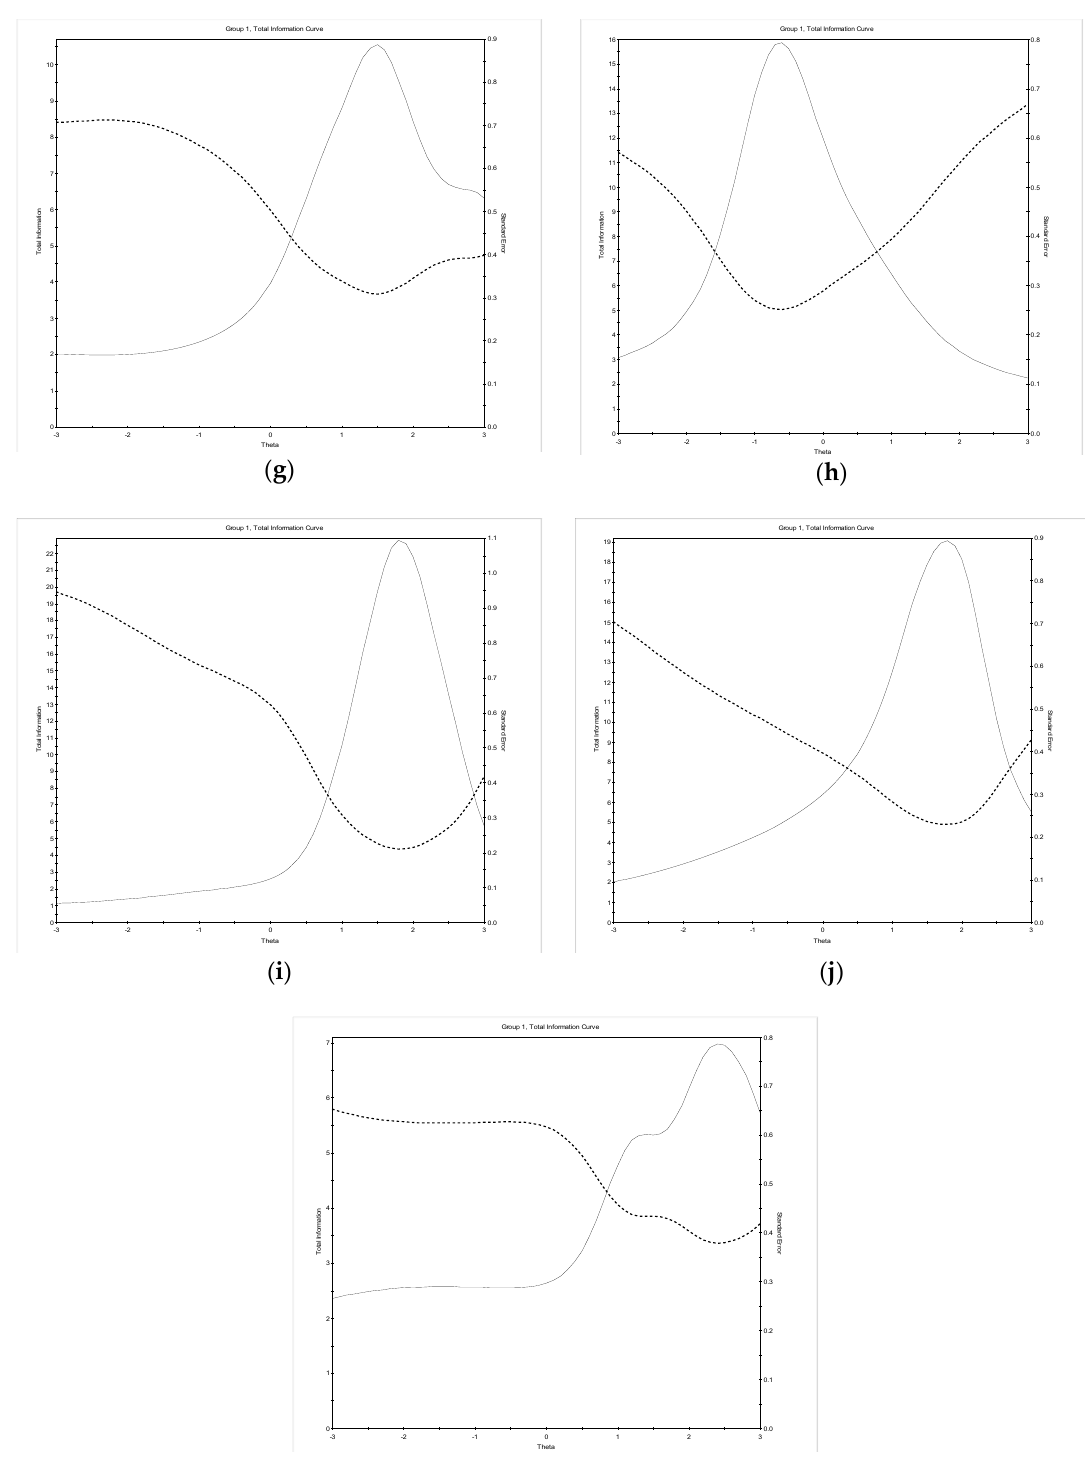
Figure 1. Test information function curve for dichotomous WAIS-IV subtests: ( a ) Visual Puzzles; ( b ) Matrix Reasoning; ( c ) Picture Completion; ( d ) Figure Weights; ( e ) Arithmetic; ( f ) Information. Test information function curve for polytomous WAIS-IV subtests: ( g ) Similarities; ( h ) Vocabulary; ( i ) Block Design; ( j ) Digit Span; ( k ) Letter-Number Sequencing.